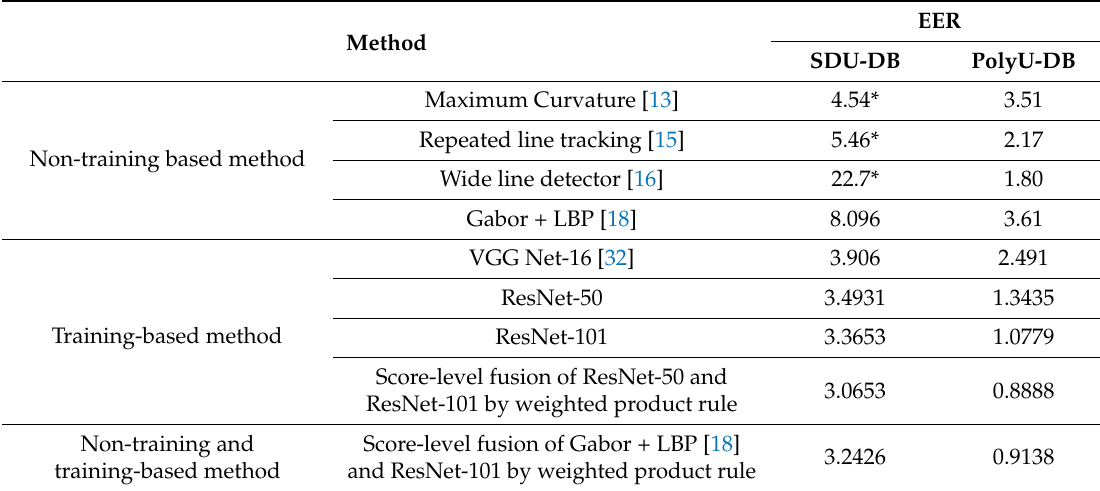
Table 5. Comparison of finger-vein recognition accuracy (unit: %) (The “number*” is referred from [19]).